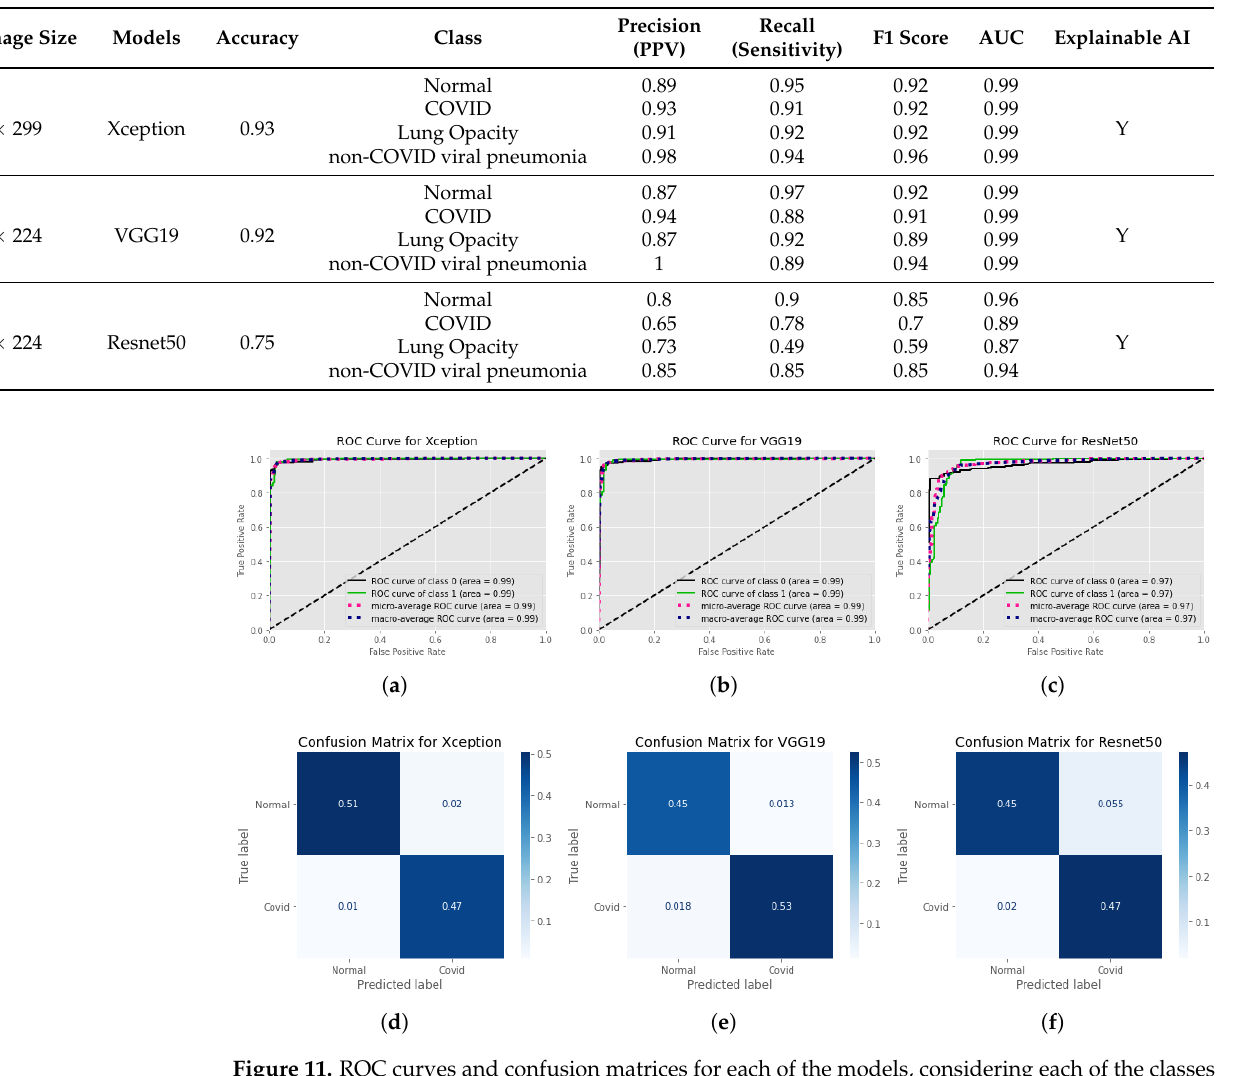
Table 3. Performance measures for the three models considered in the article for multi class classification.